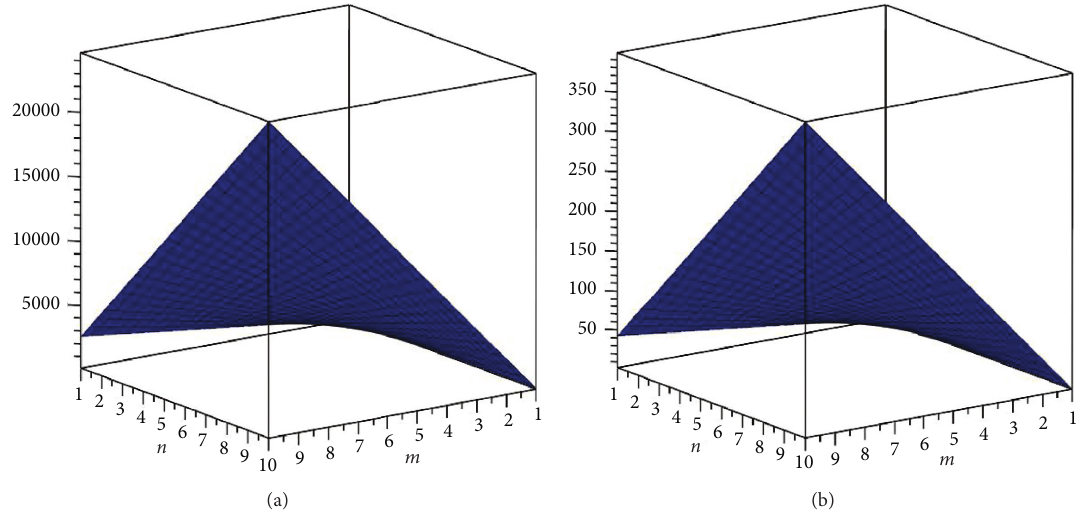
Figure 3: The ev-degree-based indices. (a) The Zagreb index. (b) The Randic